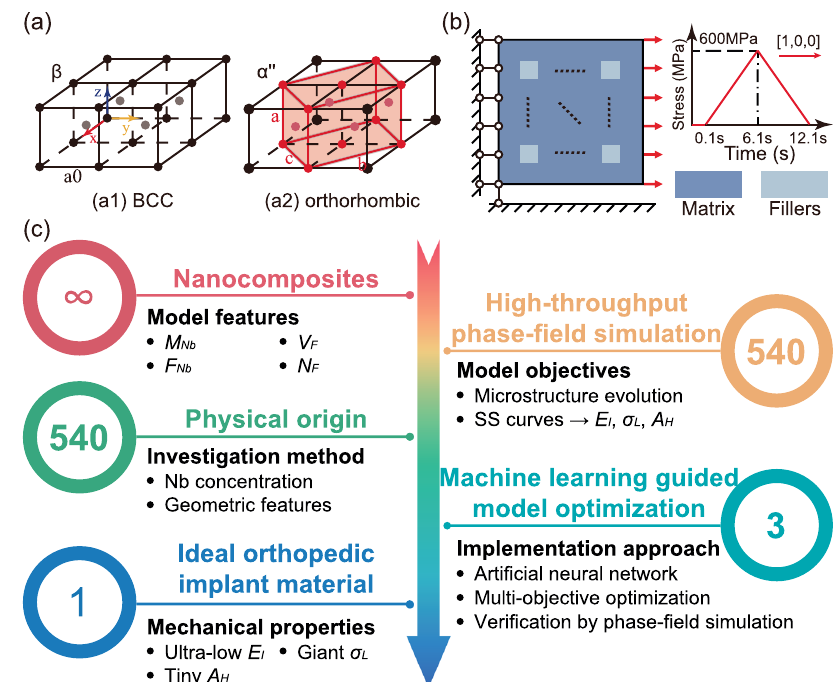
Fig. 1 The computational framework for the design of the Ti-Nb nanocomposite. a Crystal structure of parent (BCC) and martensitic (orthorhombic) phase. b Square-array distributed Nb-lean nano fi llers in the Ti-Nb nanocomposite and loading-unloading condition and pro fi le. c HTP phase- fi eld simulation framework for the Ti-Nb